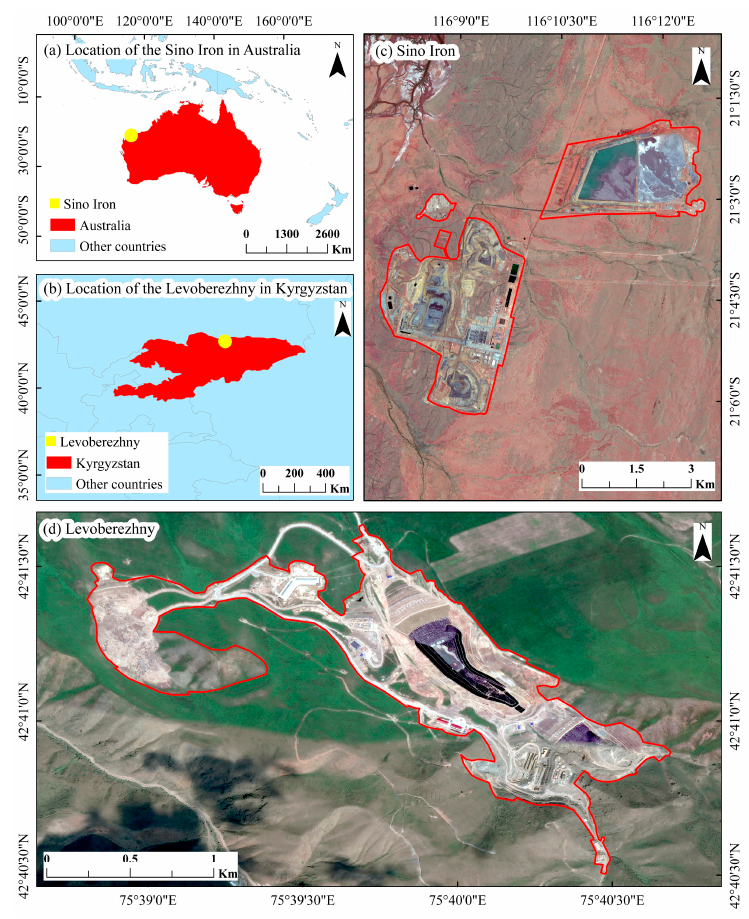
Figure 1. The location of Sino Iron and Taldybulak